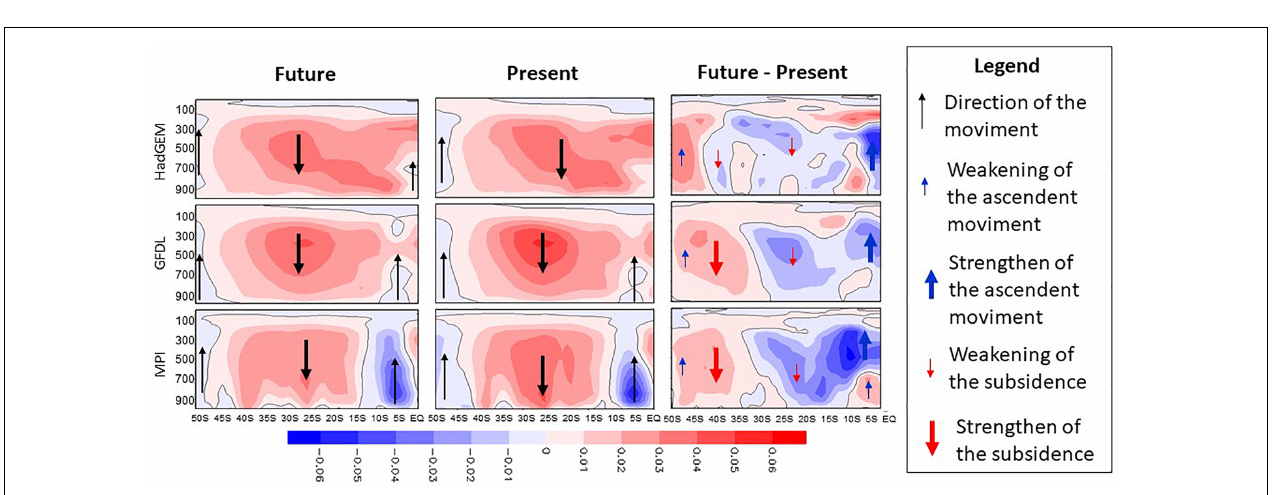
FIGURE 8 | Climatology of the 1018 and 1020 hPa isobars, for summer and winter in the present (1979–2005) and future (2065–2095) climates, from HadGEM (a,d,g,j) , GFDL (b,e,h,k) , and MPI (c,f,i,l) . Reanalyses are also presented.